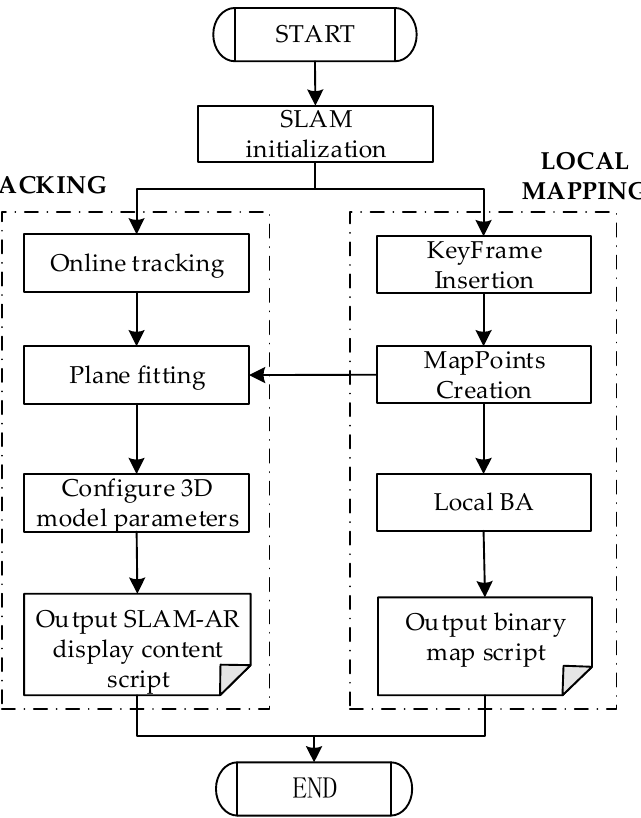
Figure 7. The flow chart of the AR display configuration module based on SLAM.